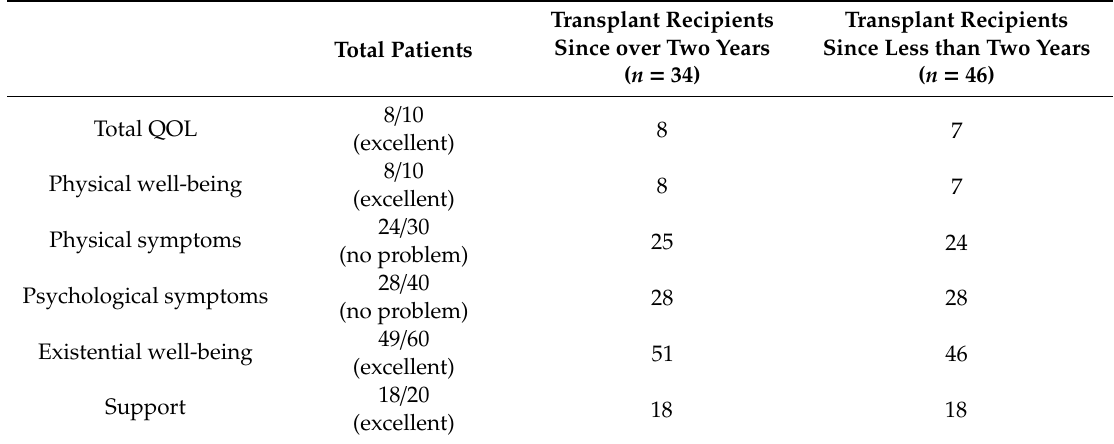
Table 2. Mean McGill Quality of Life Questionnaire © (MQOL) scales.